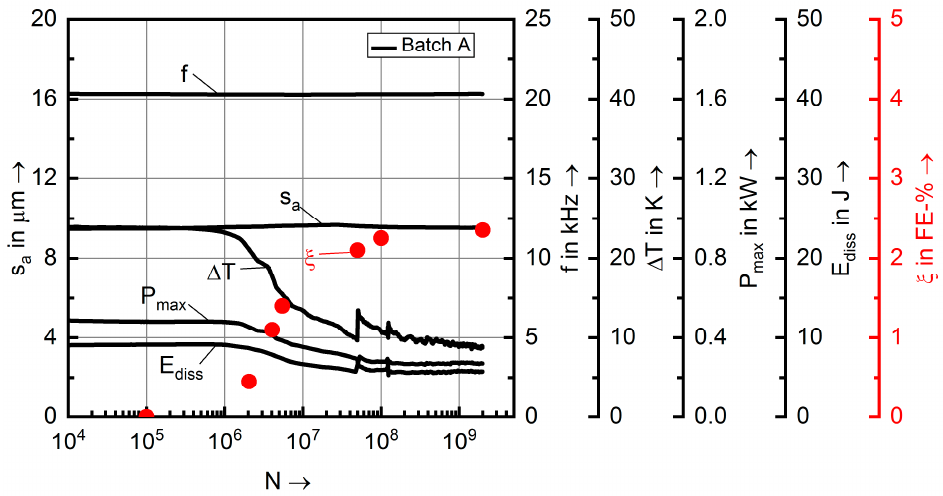
Figure 10. Displacement amplitude s a , frequency f, temperature change ∆ T, power P, dissipated energy E dis and α ’-martensite content ξ of batch A during VHCF test at σ a = 250 MPa.